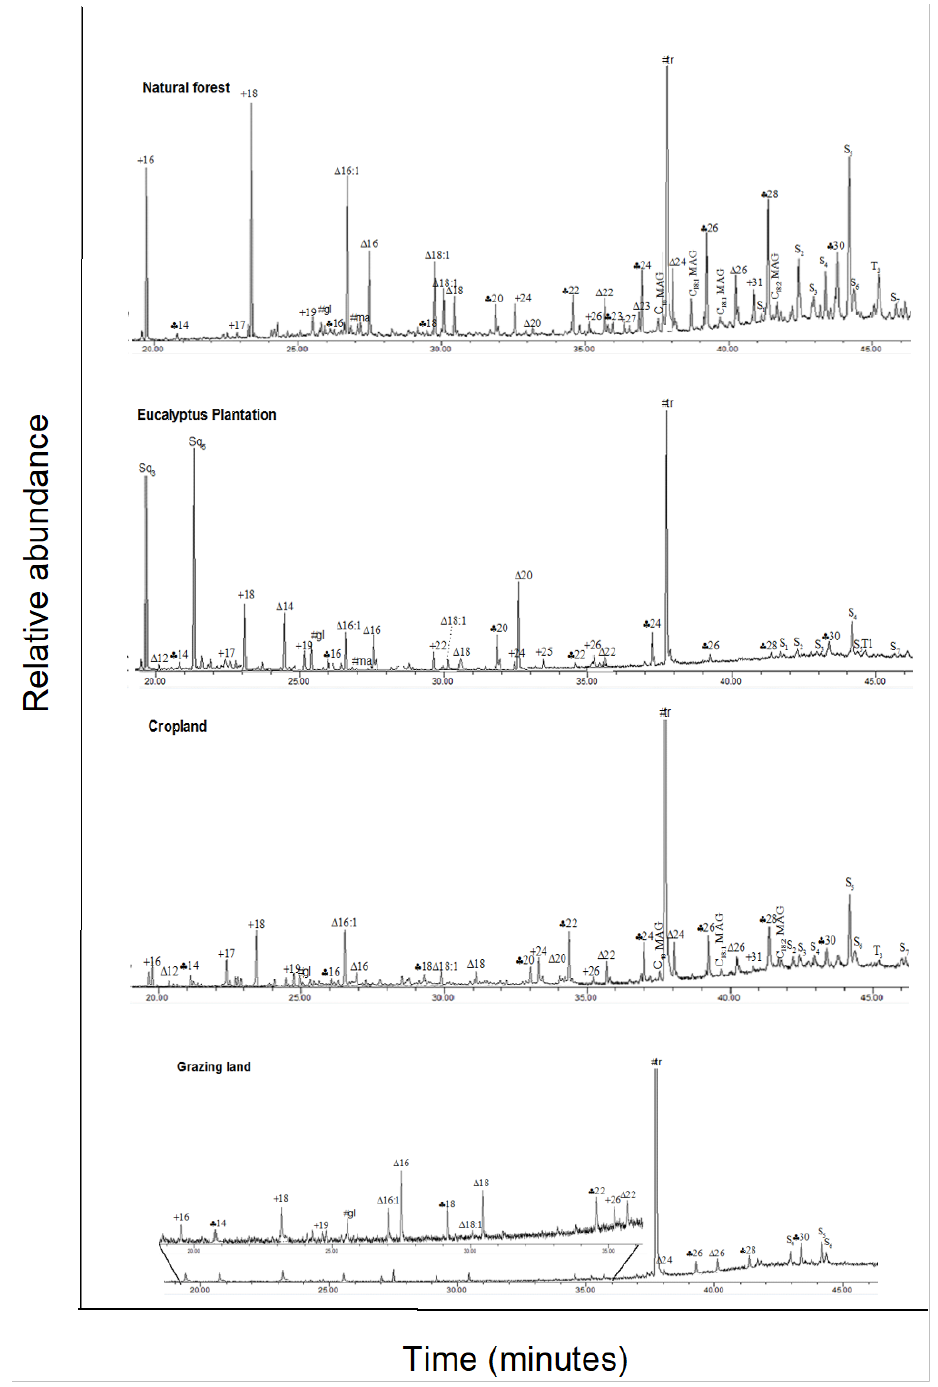
Figure A2. Total ion GC – MS chromatograms (TIC) of the silylated solvent extracts of four land-use systems from Gelawdios, Ethiopia. Notes: